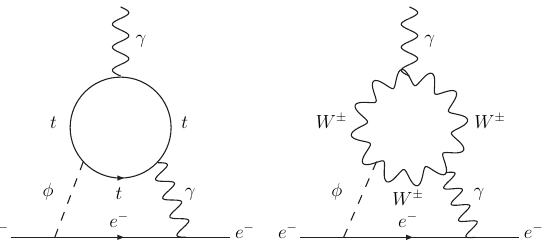
Figure 4. Two dominant diagrams for d φγ e when Im ρ ee is also taken into